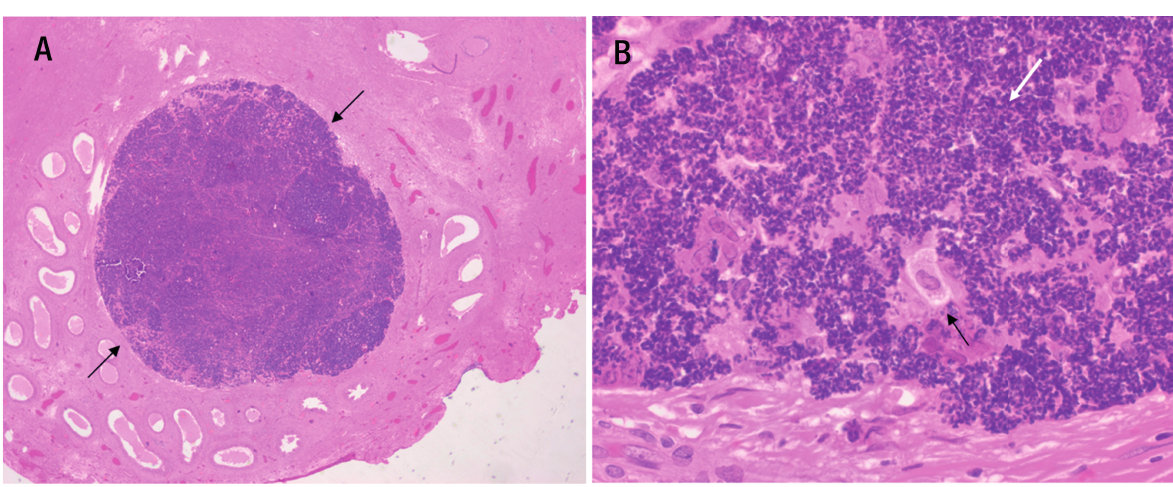
Figure 2 - (A) H-E stain 10x sperm granuloma and H-E stain 20x, (B) phagocytosed sperms in the macrophages (black arrows) delimited by histiocytic reaction and giant cells (white